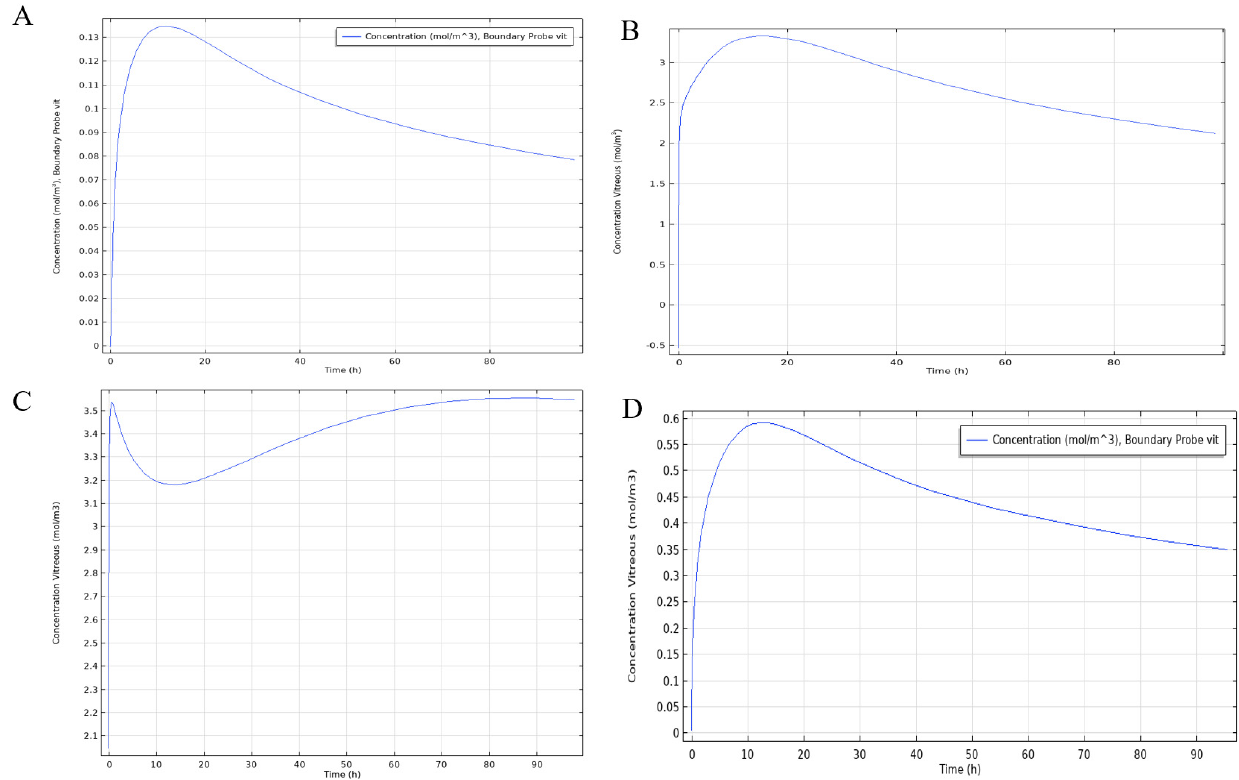
Figure 9. COMSOL Multiphysics 3D Model simulation of drug concentrations in the vitreous following entry routes originating from ( A ) the subconjunctival, ( B ) topically, ( C ) the vitreous and ( D ) the subretina; and penetrating into the vitreous.